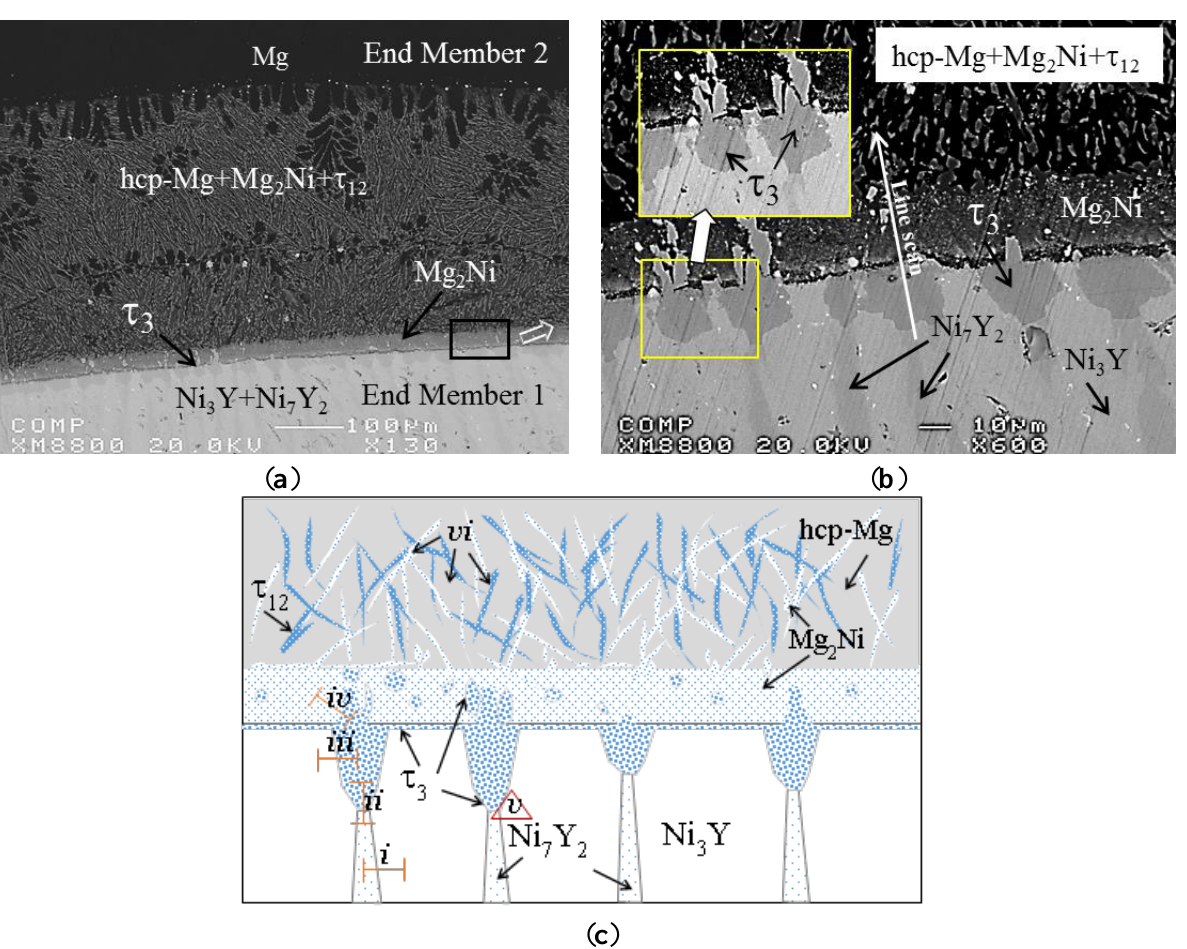
Figure 9. ( a ) BSE images of the solid–liquid diffusion couple-1 (Mg-Ni 78 Y 22 ) annealed at 673 K for 4 weeks; ( b ) Magnified area of interest; ( c ) Schematic representation of the phase relations of the diffusion zone in Figure 9b.